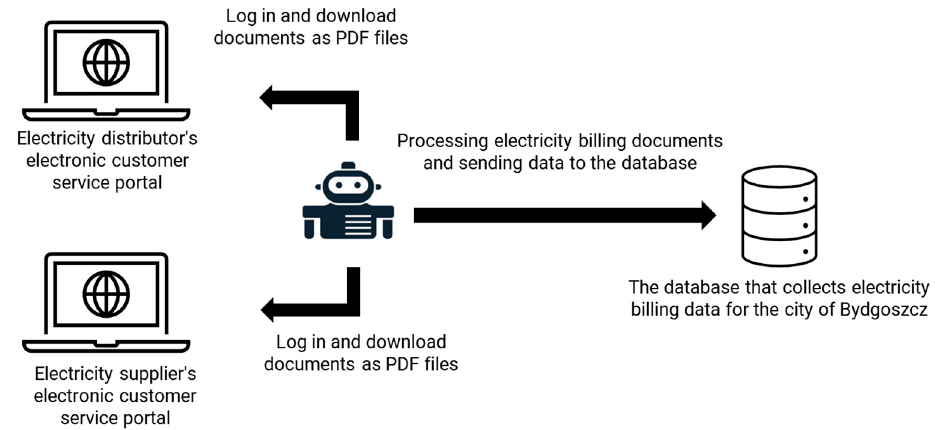
Figure 4. The operational model of the software robot developed using the RPA tool addressing the processing of electricity billing documents for the City of Bydgoszcz. Source: proprietary compilation based on [ Error! Reference source not found. ].